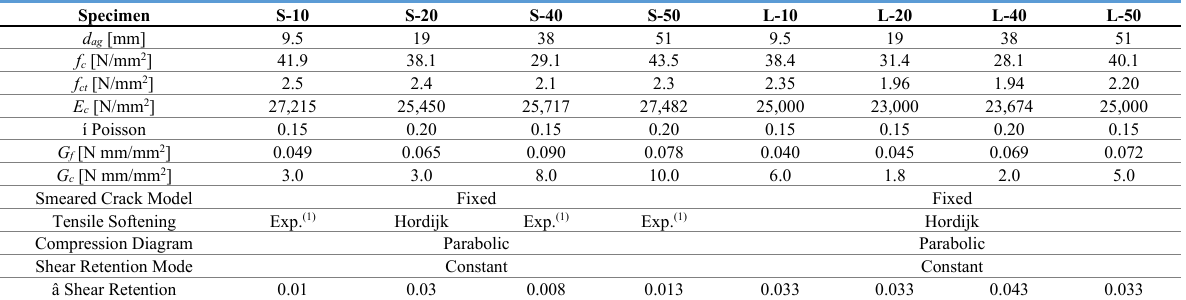
Table 3. Parametrization of concrete and steel at beams type S- and L-Series. Where: Exp. (1) refers to Exponential Tensile Softening.